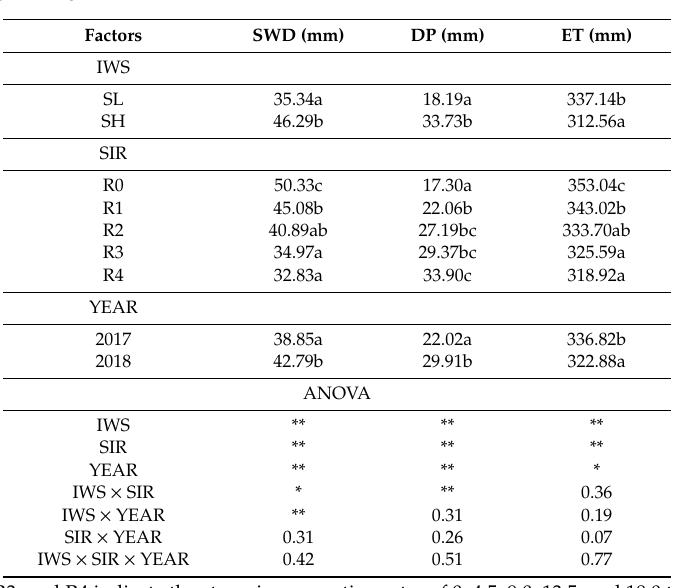
Table 3. Mean values of soil water depletion (SWD), deep percolation (DP), and evapotranspiration (ET) and results of the three-way ANOVA with irrigation water salinity (IWS), straw incorporation rates (SIR), and growing season (YEAR) as